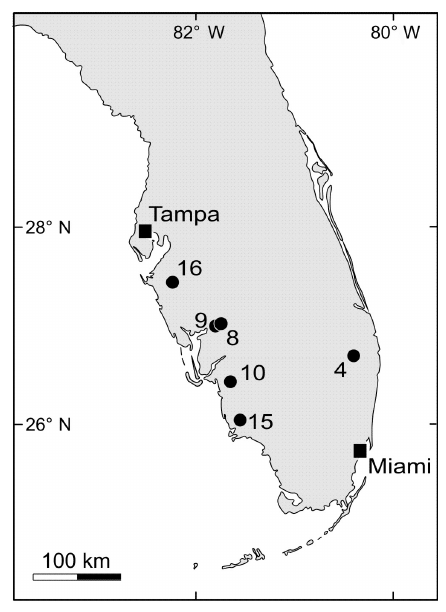
Figure 1. Sampling stations in southern Florida, USA (dots). See Table 1 for details and numbering of sampling